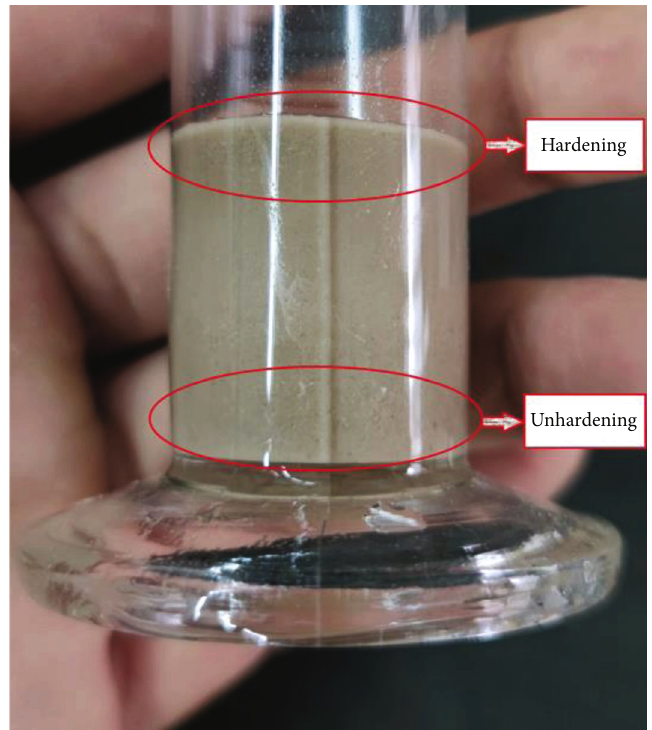
Figure 9: The hardening of Gypsum rock